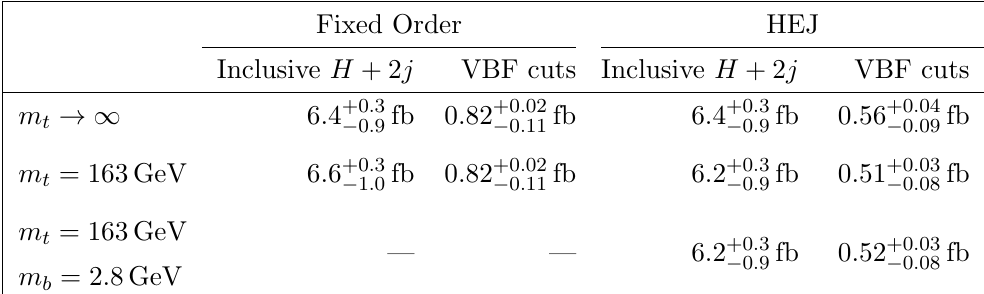
Table 3 . Total cross section predictions for the central scale choice (cid:22) values of the heavy-quark masses. See table 2 for the corresponding predictions with (cid:22) r = (cid:22) f = max( m H ; m 12